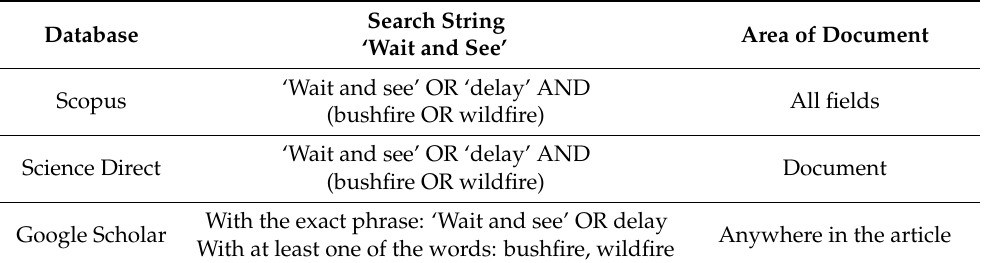
Table 1. Search string for